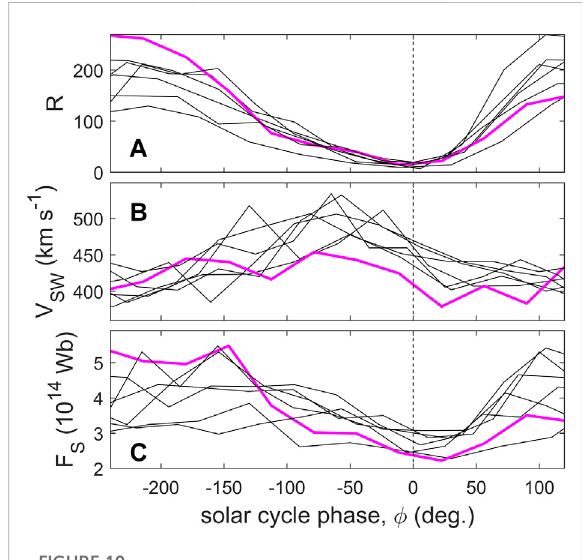
FIGURE 10 Variations with solar cycle phase ϕ of annual means of: (A) International Sunspot Number, R; (B) the solar wind speed, V SW derived from geomagnetic activity data; and (C) the open solar fl ux, F S ,againderivedfromgeomagneticdata.The V SW and F S time series are shown in Figures 9 and 12 of Paper 1 (Lockwood et al., 2022). The phase ϕ is de fi ned as zero at sunspot minimum and shown by the vertical dashed lines in each panel. The results are for sunspot cycles 17 – 24 around the MGSM peak, cycles for which thepeak annual meanRexceeded150. The variation for the sunspot minimum 19/20 is shown by the bold mauve line in all